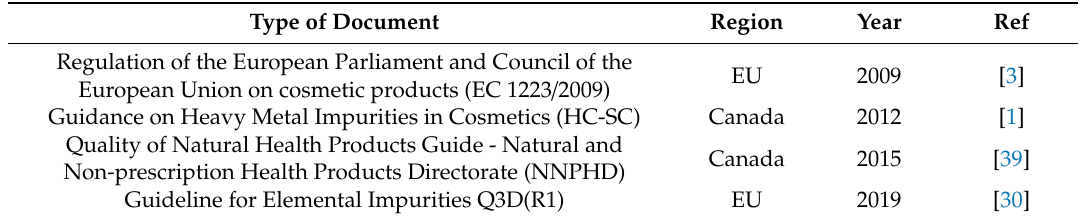
Table 1. Documents used during the interpretation and discussion of the obtained results.